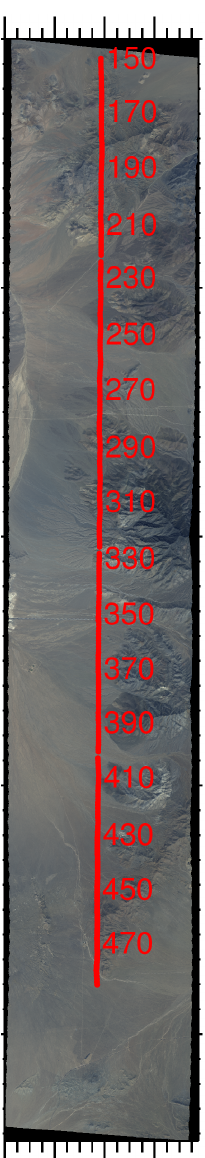
Figure 4. This image shows AVIRIS data acquired 31 March 2014 during 18:13–18:17UTC in California near the southwestern California–Nevada border. The red line shows the location of the center of nadir RSP measurements, where the numbers indicate the scan